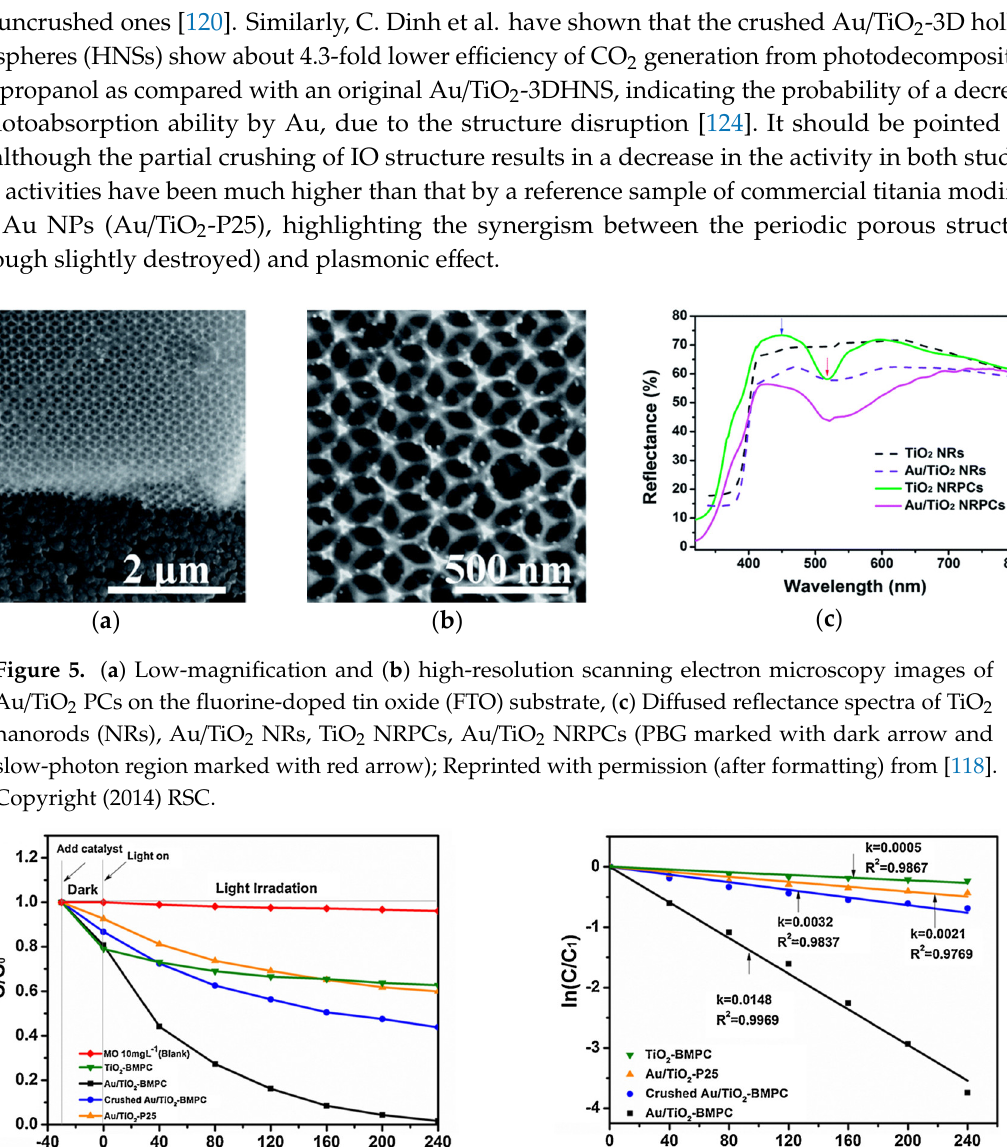
10 of 20 indicated that red-edge PBG is more effective than blue-edge one. At the red-edge PBG, the light propagate with decrease group velocity, being described as a sinusoidal standing wave that has its highest amplitude in the high refractive index part of the PCs, whereas the standing wave at blue edge is localized in the low-refractive index part. Accordingly, an absorber at high dielectric part has stronger interactions with light at red-edge regions of PBG. Similarly, IO-molybdenum: bismuth vanadium (Mo:BiVO 4 ) photoelectrode with infiltrated Au NPs has shown an increase in PEC water splitting, and the enhancement has been attributed to the amplified LSPR effect when the polystyrene (PS) template of 260-nm particles results in PBG at 513 nm, synergistically matching with the LSPR